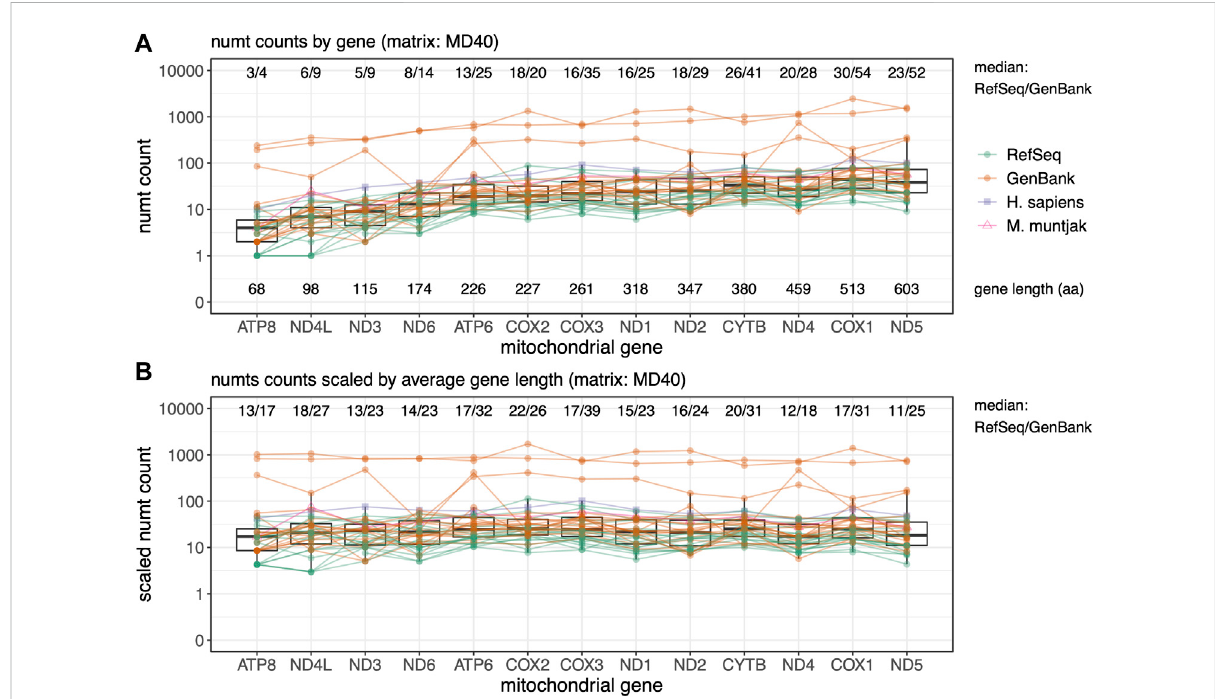
FIGURE 4 Rodent median numt counts for mtDNA protein genes found using TFASTX with the MD40 scoring matrix. Genes are sorted by length from shortest to longest. GenBank genomes are colored orange and RefSeq colored green with M. muntjak colored in pink and H. sapiens colored in purple. (A) Total counts per gene ordered by gene length in amino acids (aa); (B) Numt counts scaled by average gene length. Lines connect numt counts from mtDNA genes in the same